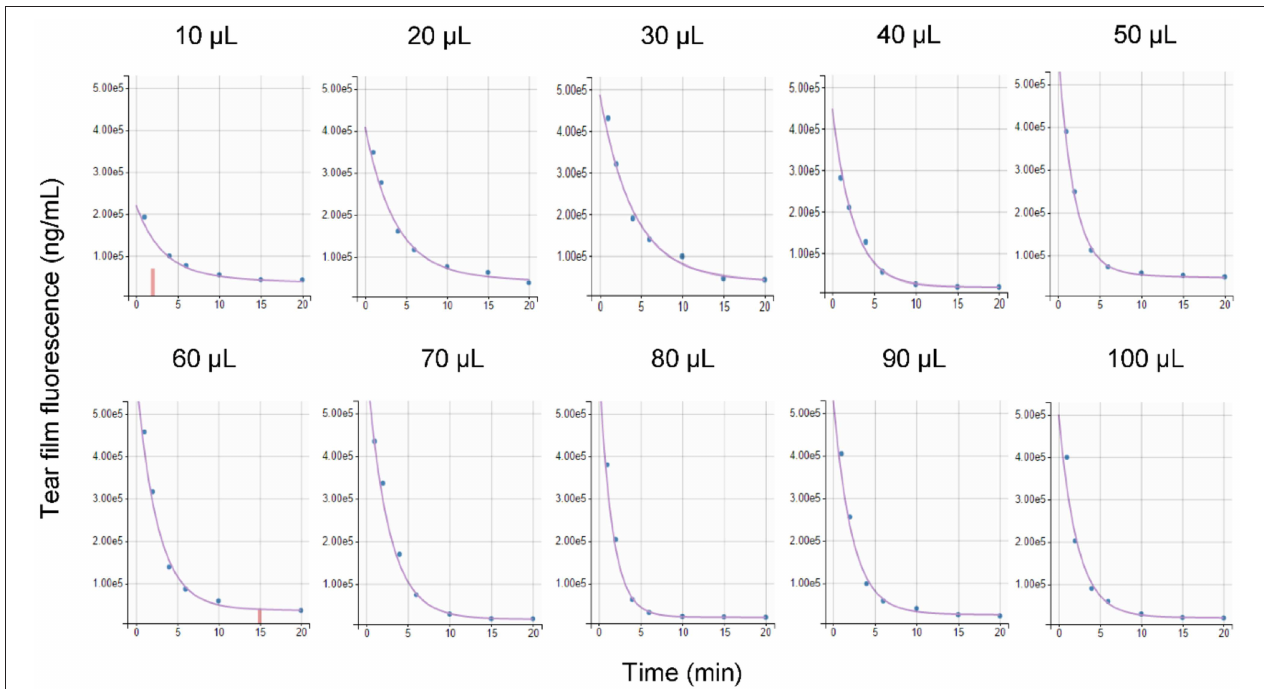
FIGURE 6 | Comparison of predicted tear fluorescence over time (purple curve) with observed data (blue points) following topical instillation of 0.1% fluorescein solution (10–100 µ l) in a representative Beagle dog. Censored data are shown as vertical red bars.